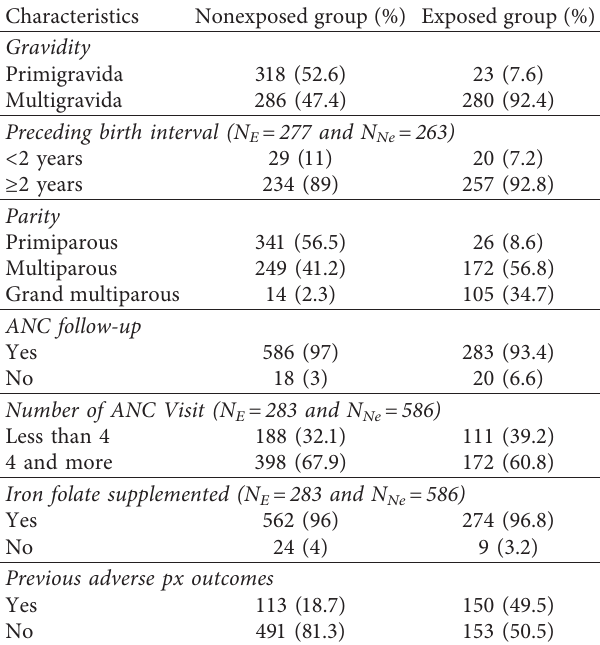
Figure 1: Distribution of wealth quintile of the participants in Debre Markos referral hospital, Northwest Ethiopia, 2019 ( N E � 303 and N Ne � 604). Table 2: Distribution of obstetrics related characteristics over grouped maternal age in Debre Markos referral hospital, Northwest Ethiopia, 2019 ( N E � 303 and N Ne � 604).